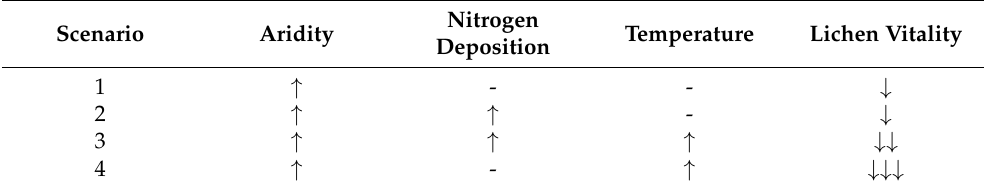
Table 3. Projections for the vitality of Cladonia and other lichens with similar ecology based on four global change scenarios for the next century. Components of each scenario were gathered from the literature, and predictions for lichen vitality were made based on outputs from this study. Arrows pointing upward indicate an increasing tendency, while those pointing downward represent a decrease. More arrows indicate a greater effect.